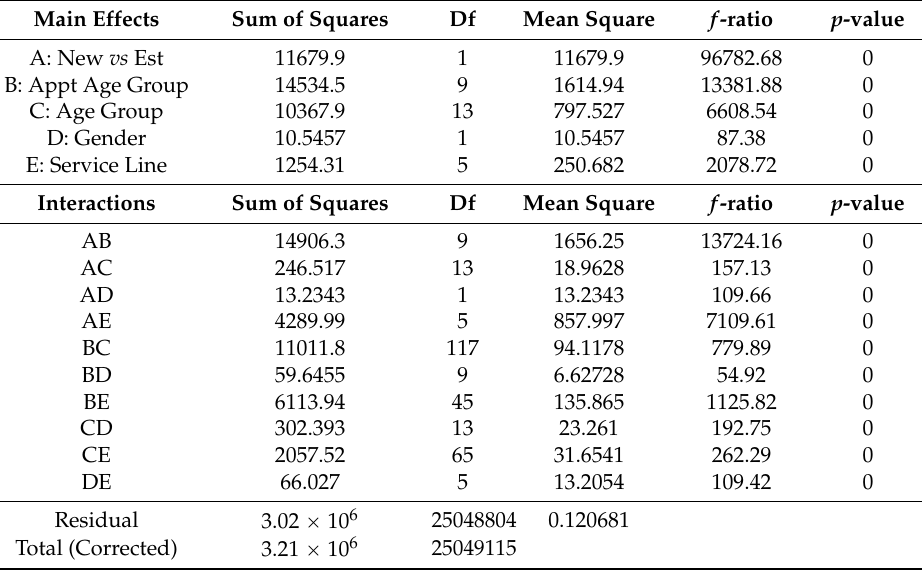
Table 1. Analysis of variance results for no-show rate—Type III sum of